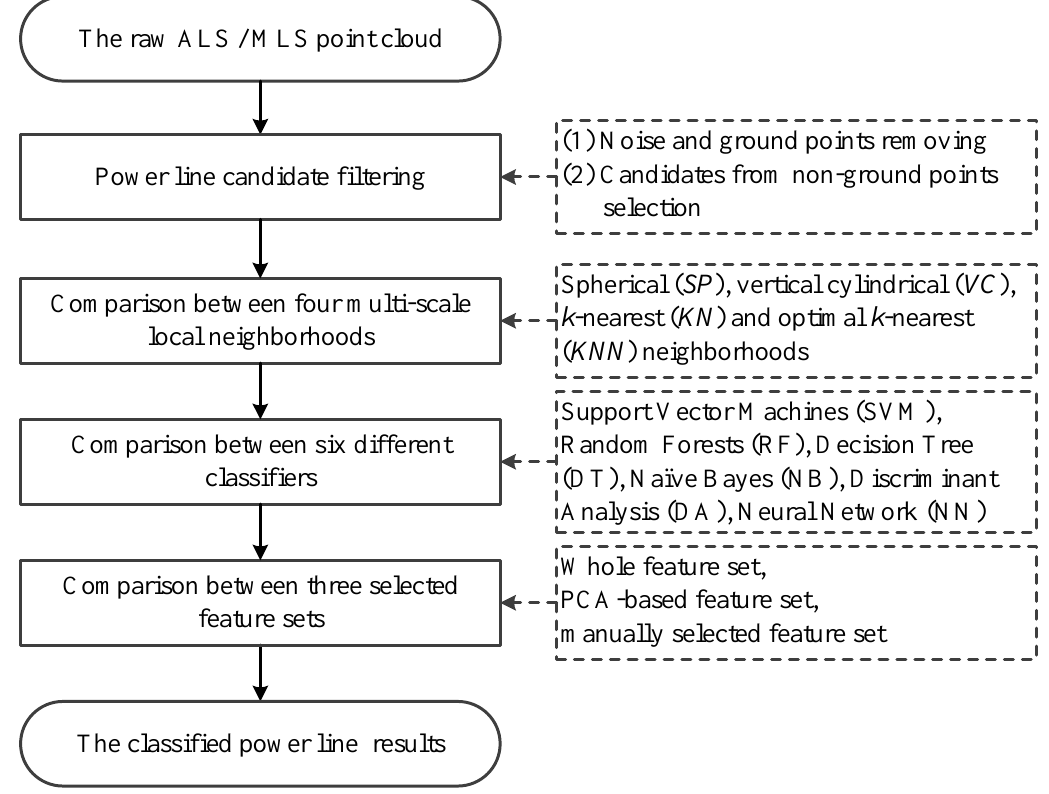
Figure 1. The whole flowchart framework of our study (ALS = airborne laser scanning, MLS = mobile laser scanning, and PCA = principal component